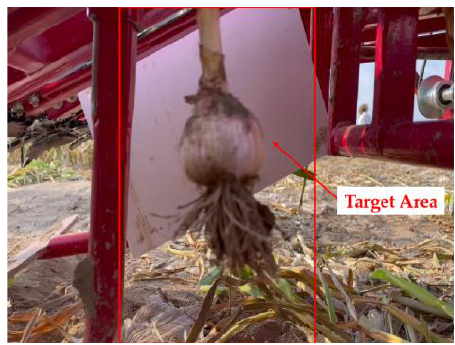
Figure 7. Target area